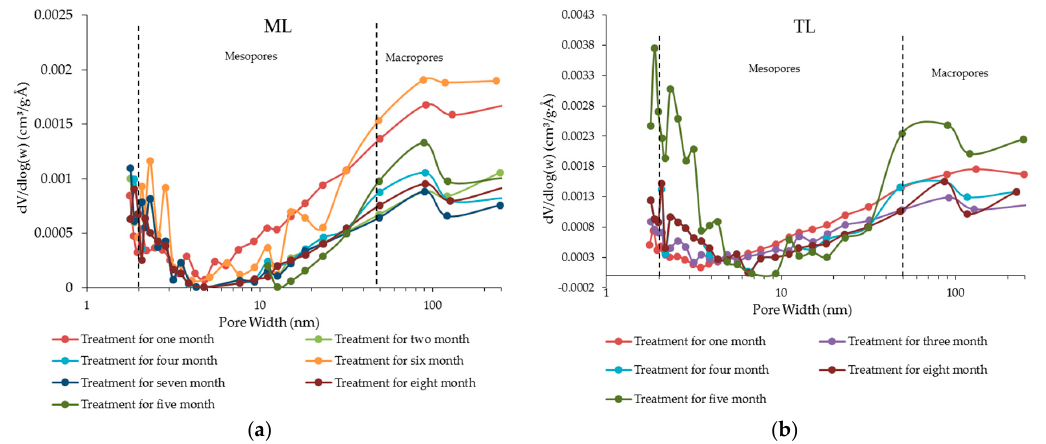
Figure 8. Distributions of BJH pore size for Malan (ML) and Tunlan (TL) samples before and after treatment: ( a ) ML and ( b ) TL.